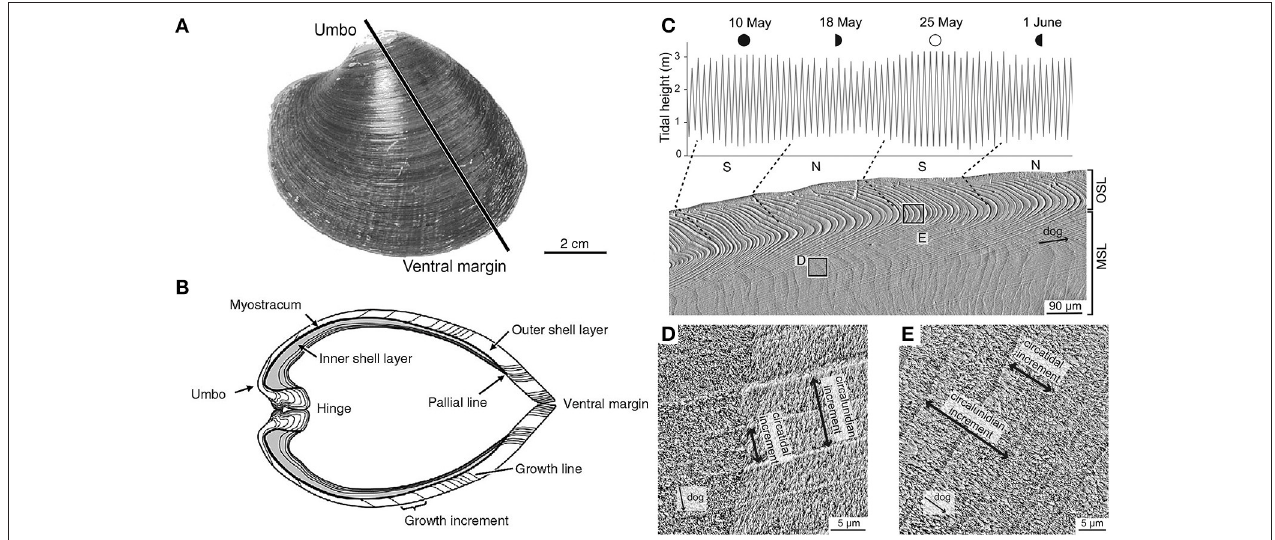
FIGURE 2 | Morphological and microstructural features of the shell of Arctica islandica (left). (A) Outer shell surface of the left valve. The black line indicates the typical transect for cross-section. (B) Umbo-ventral margin cross-section as indicated in (A) ; this exposed surface is the typical site for high resolution geochemical sampling. Microstructure of Cerastodernum edule (right) showing (C) periodic banding with tidal resolution and (D,E) characteristic microstructural and crystallographic features, which show a high correlation with seawater temperatures. ( A,B adapted from Schöne, 2003 C–E adapted from Milano et al., 2016).